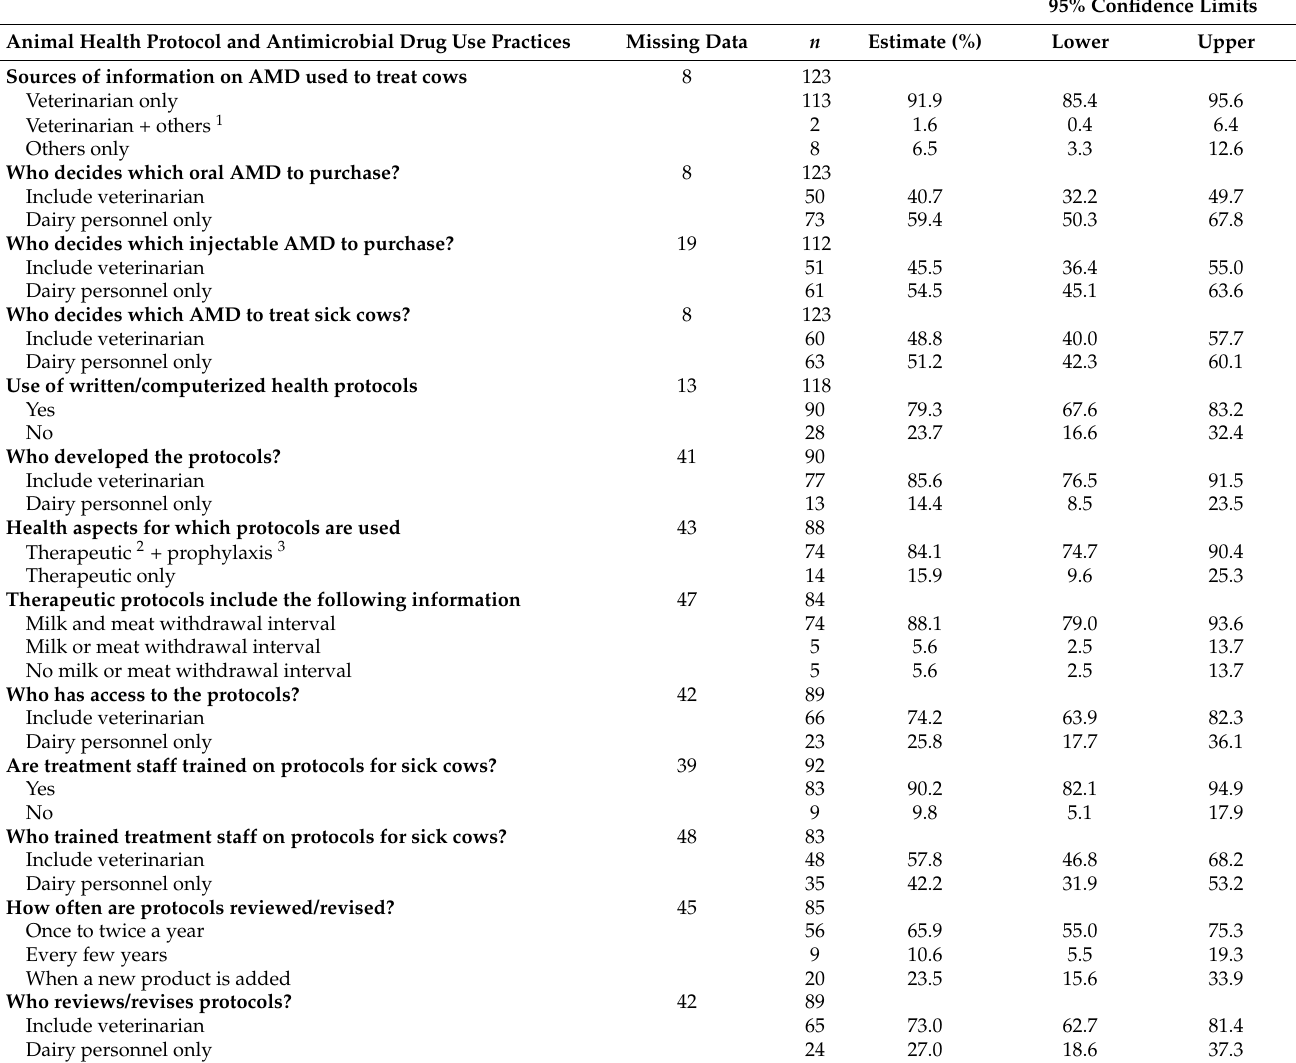
Table 4. Summary of responses to questions about dairy cow health protocols and treatment practices from responses to a questionnaire on antimicrobial drug (AMD) use in adult cows on California dairies during 2019.